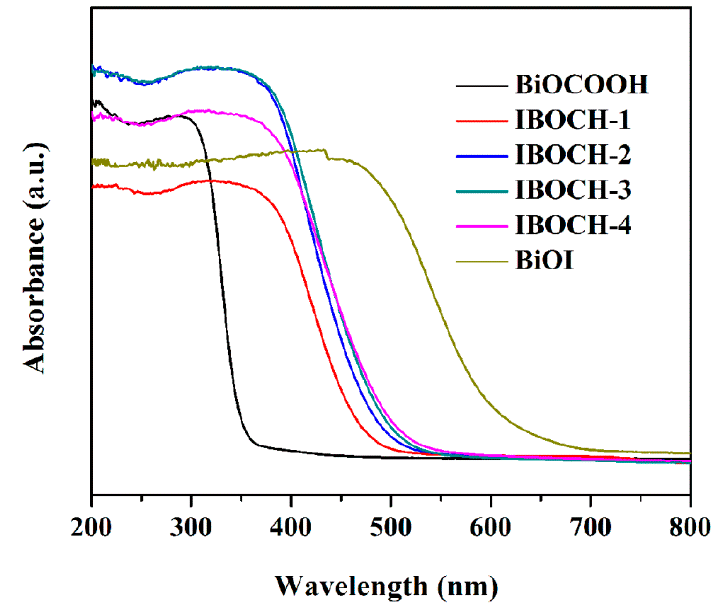
Figure 5. UV ‒ Vis DRS of the as-fabricated BiOCOOH, BiOI, IBOCH-1, IBOCH-2, IBOCH-3, and